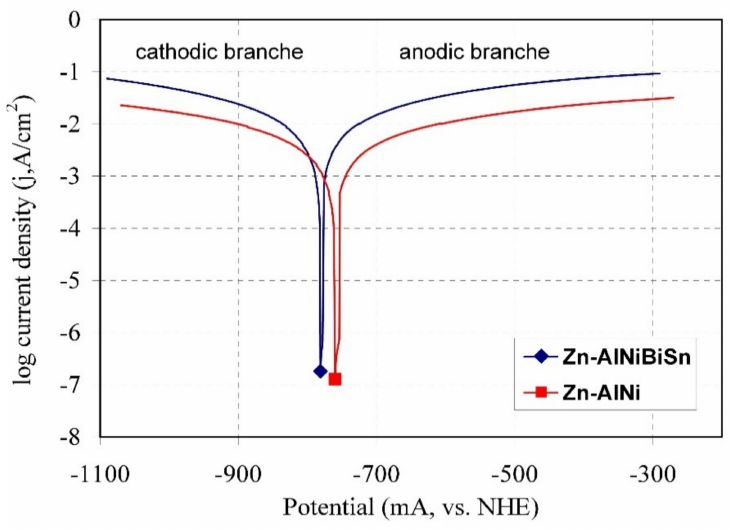
Figure 10. Anode and cathode polarization curves of the tested coatings in a 3.5% NaCl